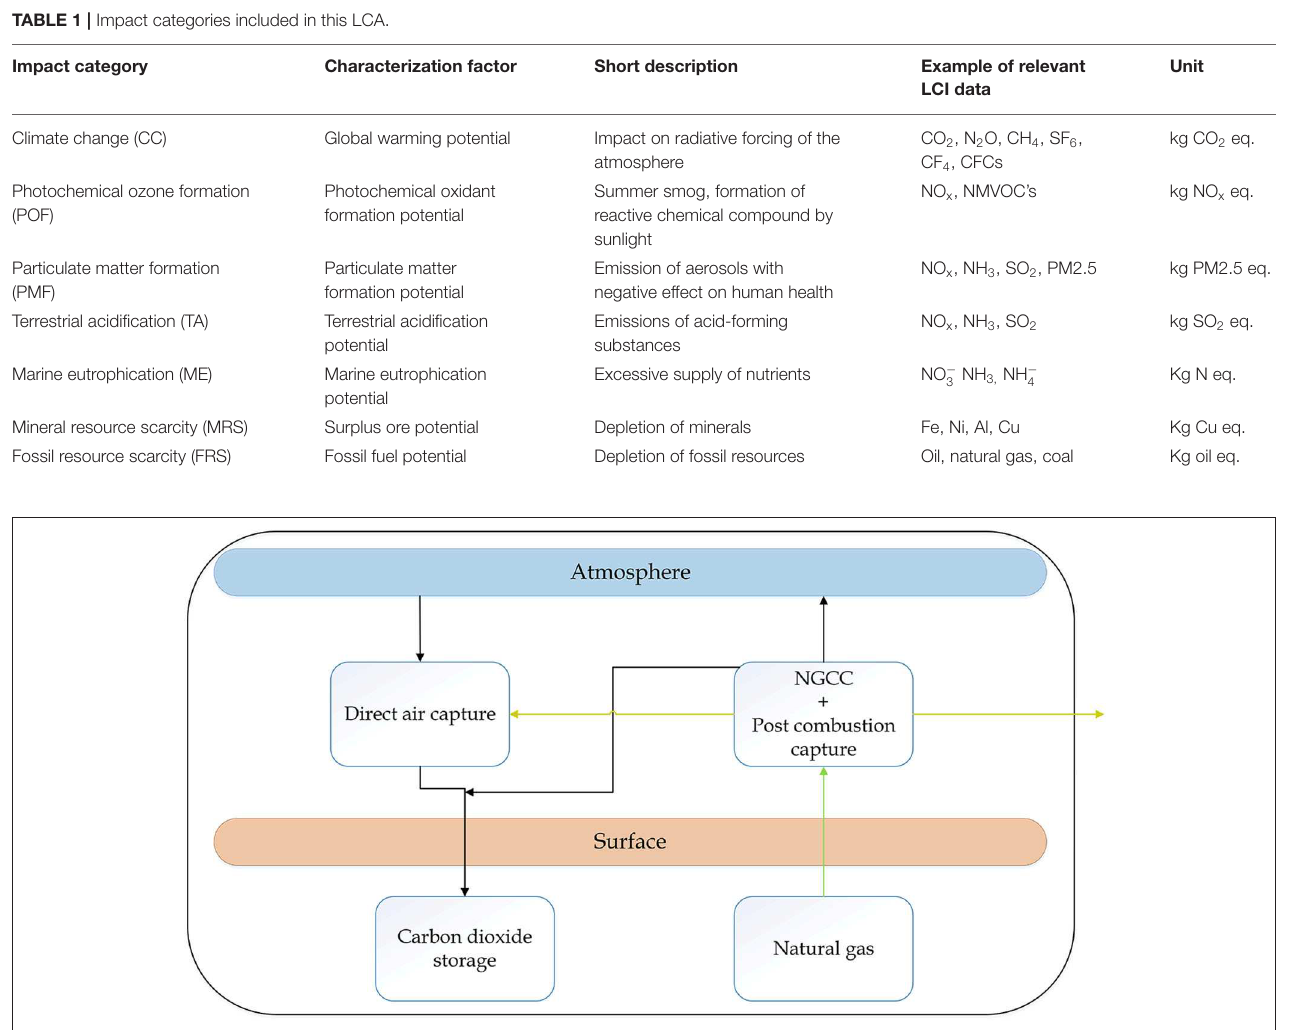
FIGURE 3 | System diagram of the future reference system (CCS): Yellow lines represent electricity, black is CO 2 and green is natural gas.